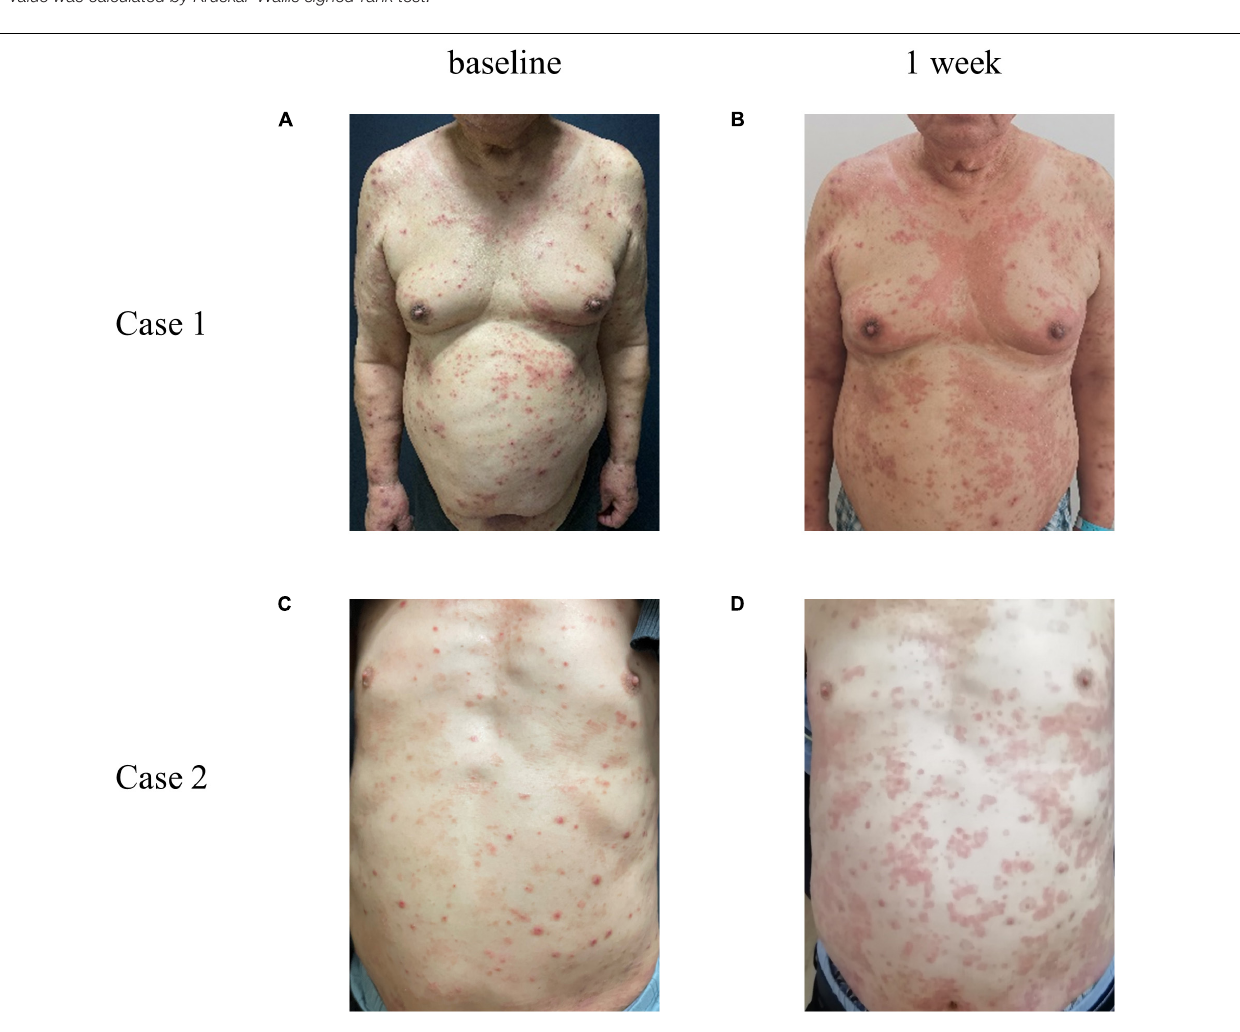
dupilumab. At 16 weeks, EASI 50, EASI 75, and EASI 90 were